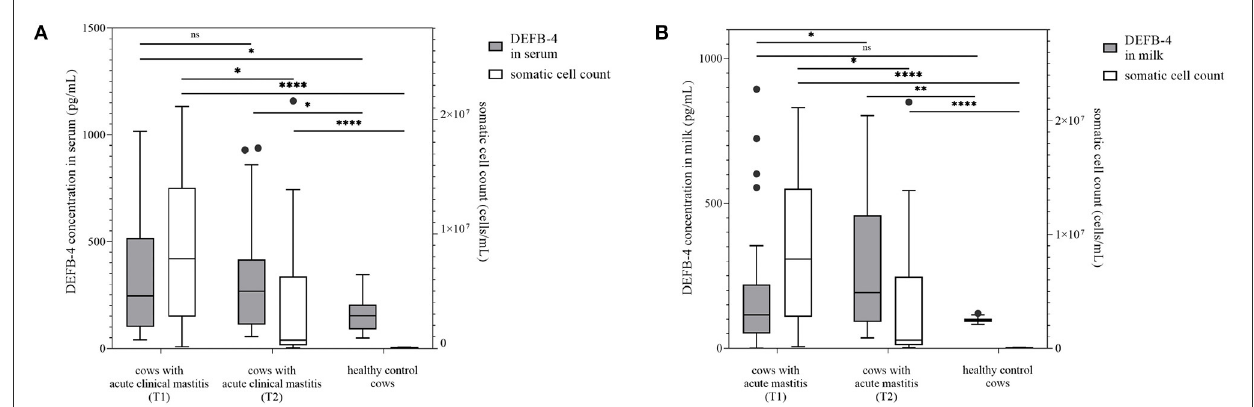
FIGURE1 DEFB-4 concentration grouped with the somatic cell count which is currently the standard parameter for the detection of mastitis. 30 cows with acute clinical mastitis at two different times were tested and compared with a healthy control group. T1 marks the time of the initial sampling and T2 the time of the second sampling 12 days later. (A) demonstrates DEFB-4 concentrations in serum and (B) shows DEFB-4 concentrations in milk. Significant changes are marked by asterisks (*) whereas “ns” means “non-significant”. The significance level is set at p < 0.05.